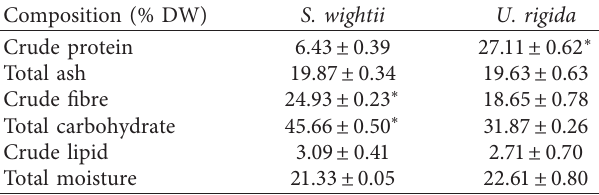
Results are expressed as mean ± ( n � 3). Values bearing ∗ are significantly different ( p < 0 . 05) from the corresponding column/seaweed in an inde- pendent sample t test. DW, dry (Western Indian coast: 8% DW) and in the Portuguese coast